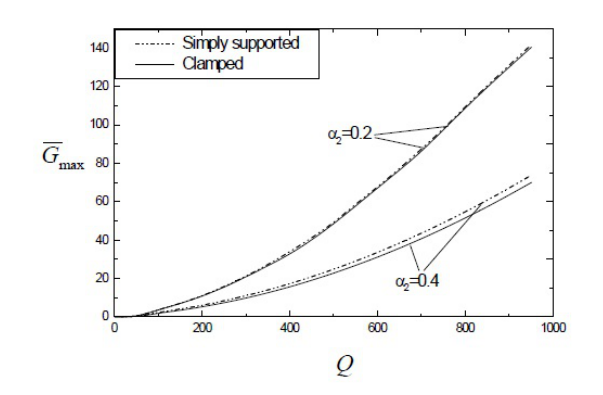
Fig. 7. Effect of delamination length on maximum of energy release rate.